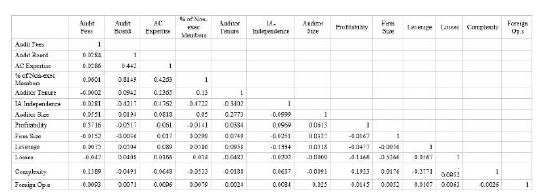
Table 3: Correlation Matrix